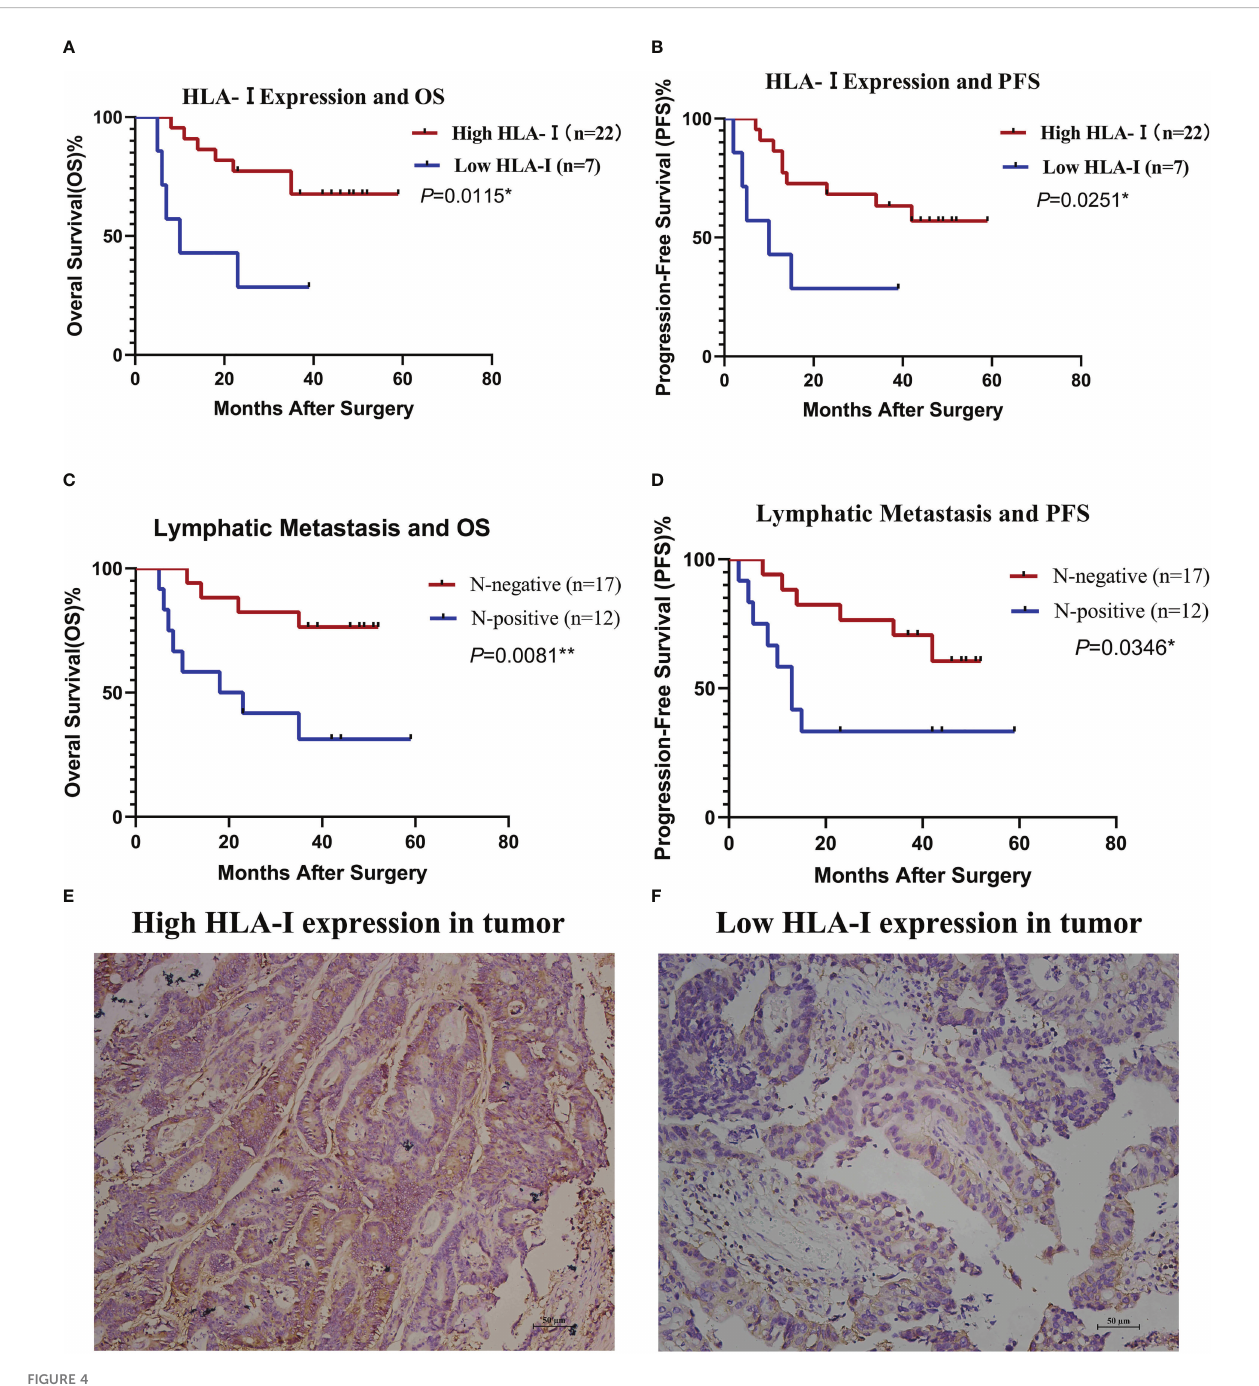
FIGURE 4 HLA-I expression and lymphatic metastasis are associated with the clinical outcome of cytotoxic T lymphocyte (CTL) infusion therapy. Strati fi ed analysis of overall survival (OS, A ) and progression-free survival (PFS, B ) based on HLA-I expression. Strati fi ed analysis of OS (C) and PFS (D) based on lymphatic metastasis status. OS and PFS were estimated by the Kaplan-Meier method. *P<0.05, **P<0.01. (E) Immunohistochemistry of a colon cancer tissue immunostained with anti- HLA-I antibodies showing high HLA-I expression. (F) immunohistochemistry of a colon cancer tissue immunostained with anti- HLA-I antibodies showing low HLA-I